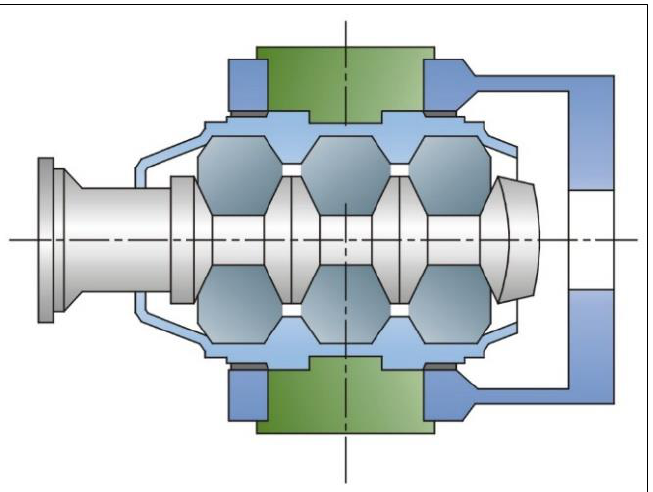
Figure 4. Jointed rubber buffer (EFG3 type) [12].